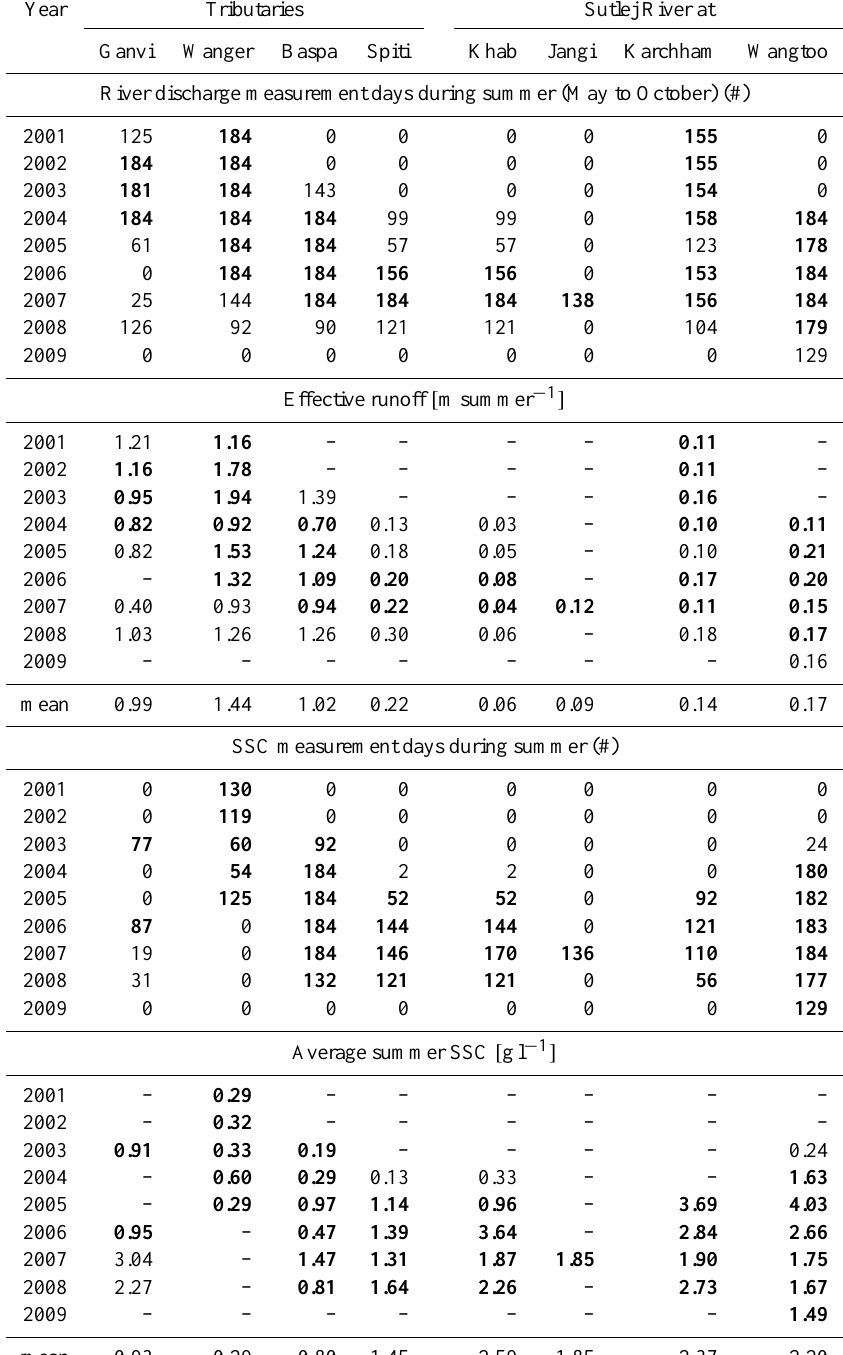
Table A1. Overview of annual effective runoff, suspended sediment concentration (SSC), effective suspended sediment load (SSL eff ) and effective suspended sediment yield (SSY eff ) during the summer half-year (May to October) for the Sutlej River and its tributaries gauging stations. Bold number indicate years accounted for to calculate the respective gauging station